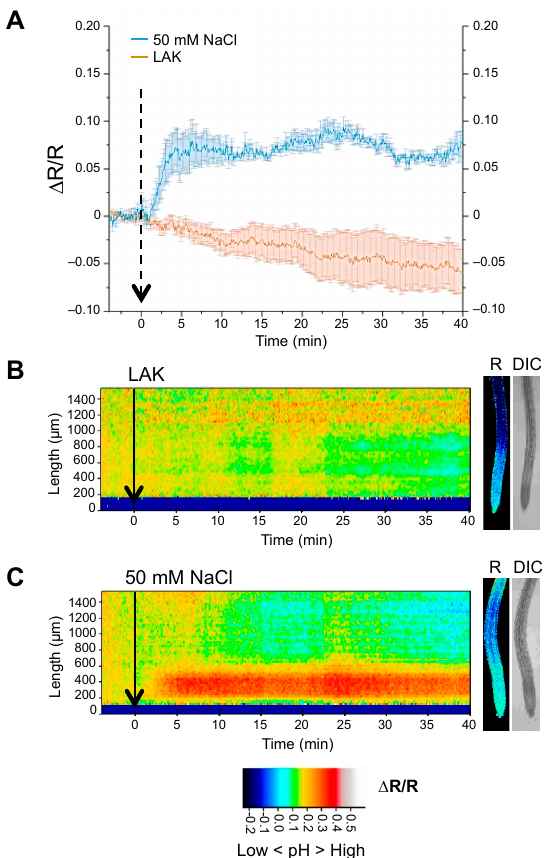
Figure 3. Cytosolic pH variations under salt stress near the plasma membrane. Seedlings of the Arabidopsis line expressing pHGFP-LTI6b were treated with either LAK medium ( B ) or LAK supplemented with 50 mM NaCl ( C ). ( A ) Normalized emission ratio ( Δ R/R) changes of pHGFP-LTI6b with and without salt treatment; lines indicate the mean of emission ratio of the MEZ segment ± SEM. ( B , C ) Heat-maps of normalized data derived from 64 adjacent regions (268.2 × 24.2 μ m). Small pictures at the right of the heat-maps show fluorescence emission ratio (R) and bright-field (DIC) images of representative at 35 min time point. Arrows in the three panels indicate the beginning of the treatment. Heat-maps and roots pictures correspond to a representative experiment from 5 to 6 independent experiments.